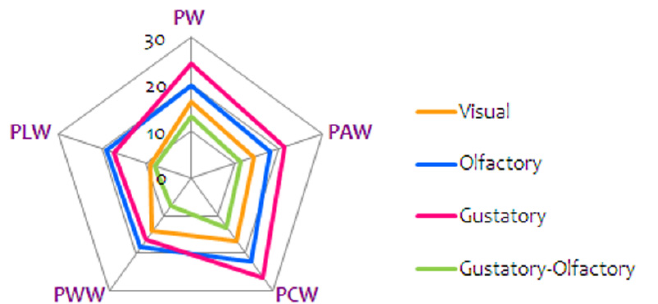
Figure 2. Sensory characteristics of ‘Prokupac’ wines; control and aromatised with medicinal herbs